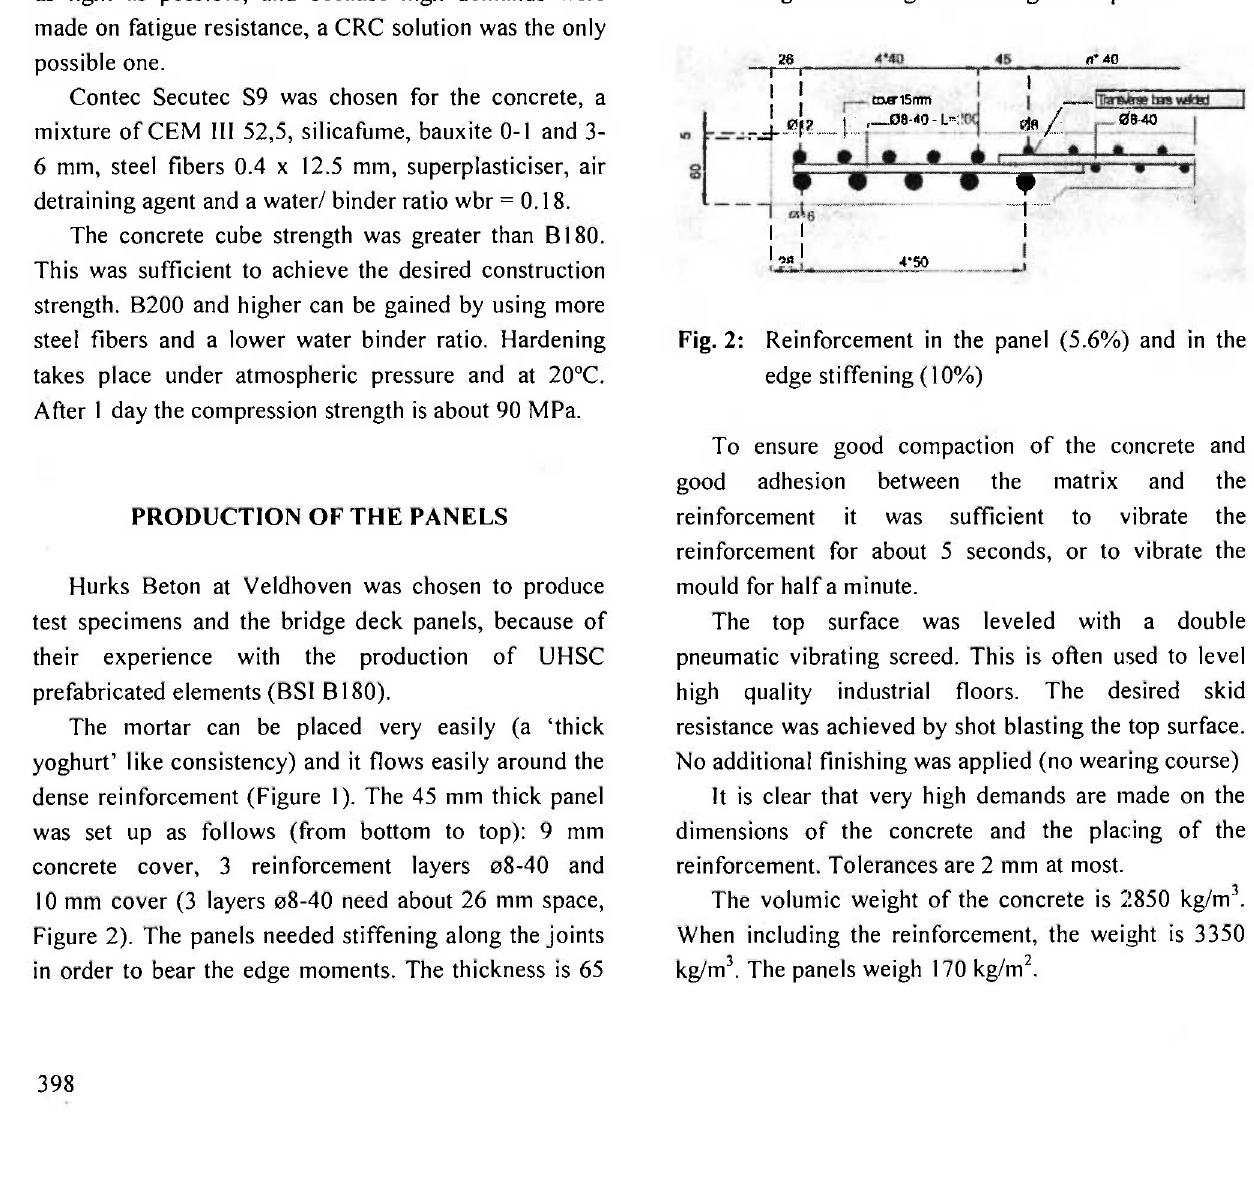
Fig. 1 : Casting of the bridge deck panels